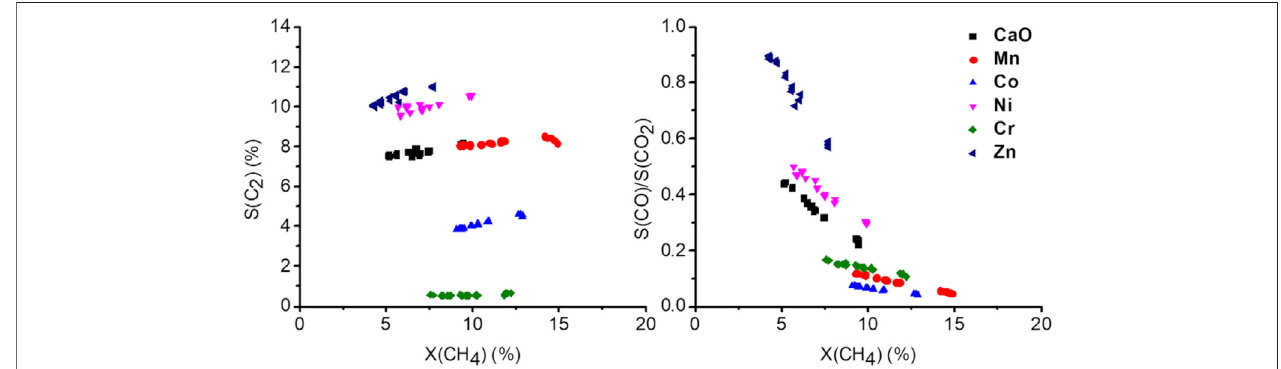
FIGURE7| Selectivity-conversionplotsat750 ° Cbyadjustingthetotalgas fl owrate(from37.5 ml/minupto150 ml/min,50 mgcarbonateprecursor,750 mgSiC, CH 4 :N 2 : O 2 =